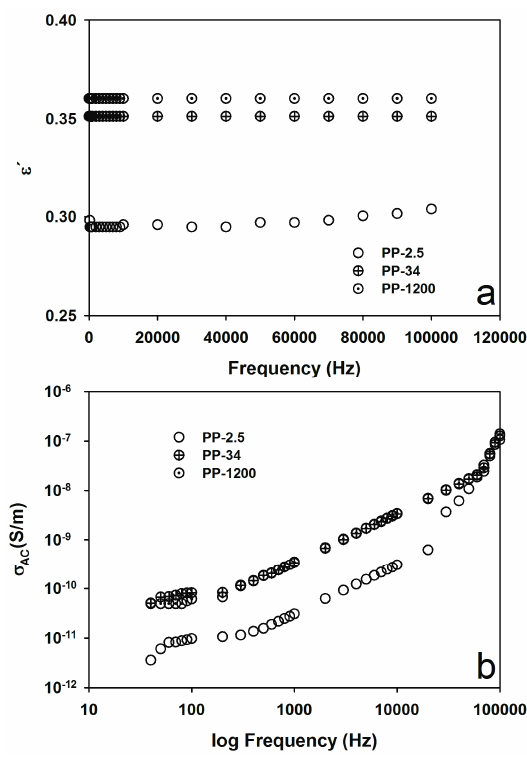
Figure 1. Electrical properties of iPP with different MFIs (2.5, 34, and 1200 g/10 min). ( a ) ε′ and ( b ) σ (AC)